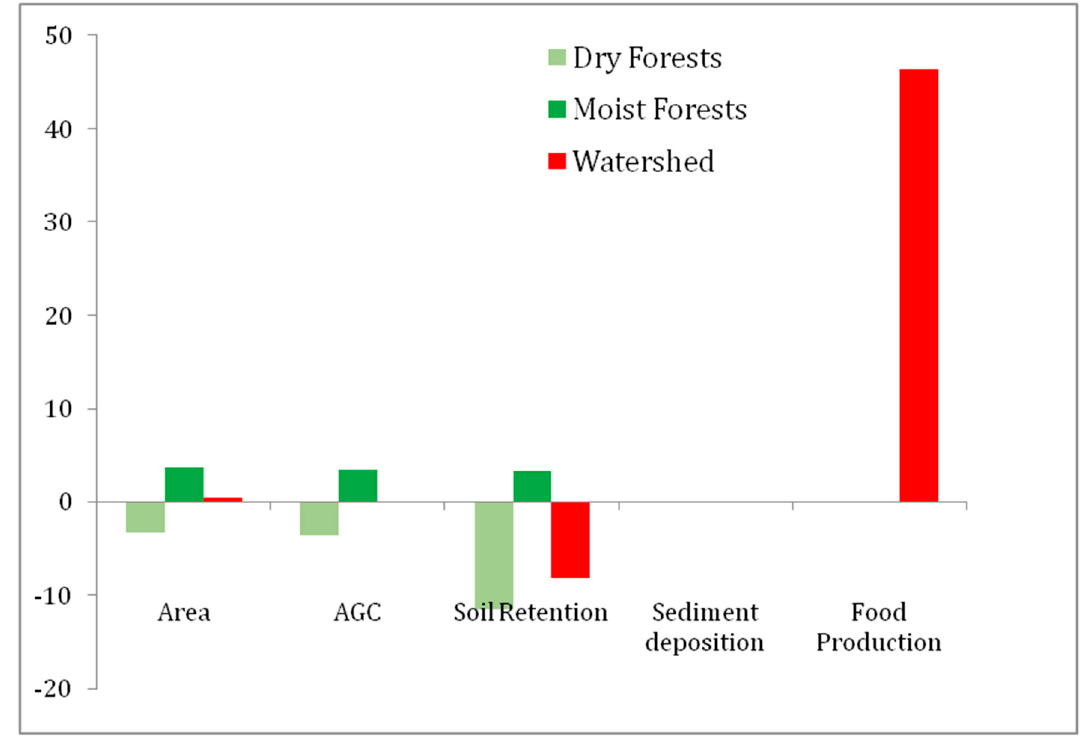
Figure 2. Percentage change in forest area (area; as a proportion of total forest area), above-ground carbon (AGC), soil retention, sediment deposition, and food production between 1986 and 2006; with and without discriminating among forest types (watershed, red bar; dry and moist forests, light green and dark green bars, respectively).